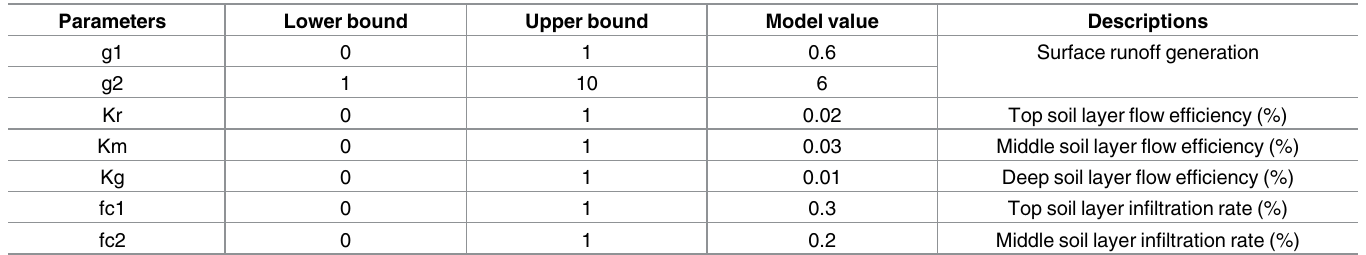
Table 3. Parameters and their optimized values for MS-DTVGM in the Yarlung Zangbo River. Parameters